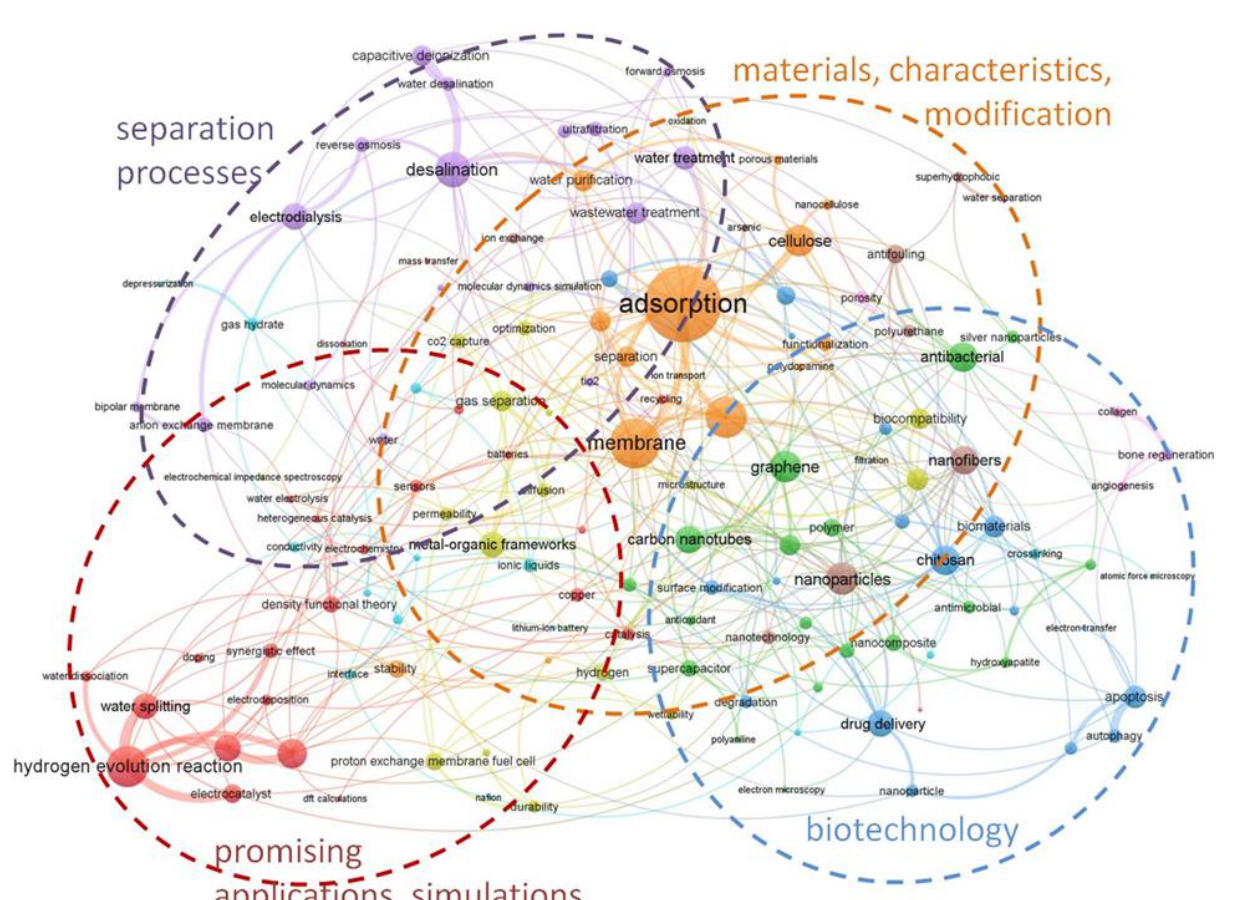
Figure 2. Membrane science map 2021. A co-occurrence network built using words found in titles and excerpts from documents published in 2021 (January to July).